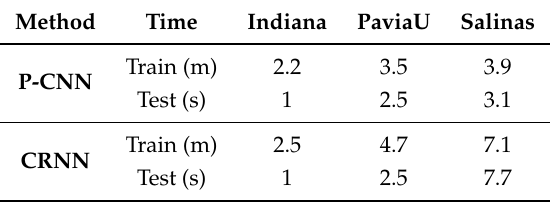
Table 8. The computational time (min: minutes, s: second) of the 3-D-LSTM-based models for the three